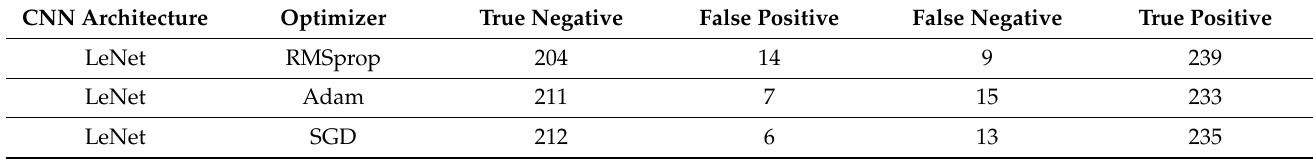
Table 2. LeNet confusion matrix